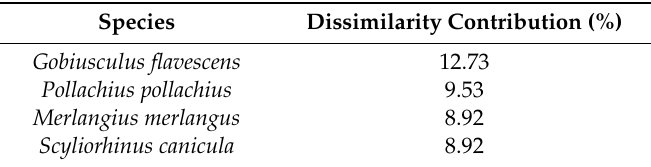
Table 3. Inter-habitat dissimilarity, showing the top four fish species present and their percentage of contribution (%) to differences in seagrass and kelp communities from BRUVS deployments across the UK